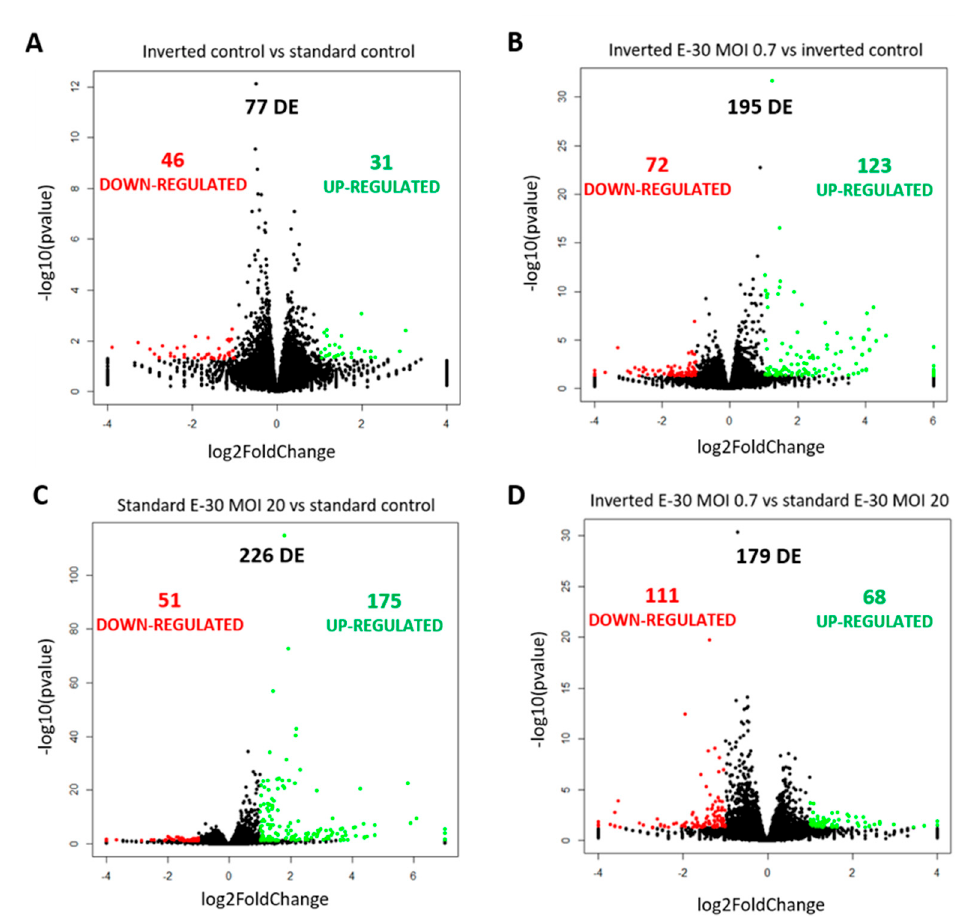
Venn diagram representing differentially expressed genes ( A ) and pathways ( B ) following infection of HIBCPP cells with E-30 from the apical (standard E-30 MOI 20) or basolateral side (inverted E-30 MOI 0.7), versus the respective uninfected control conditions (inverted control and standard control). Comparisons resulted in a p -value and log2-fold change (log2FC) for every gene for the 3 experiments. Genes with p < 0.05, and a │ log2FC │ > 1 were considered as differentially expressed ( n = 3).